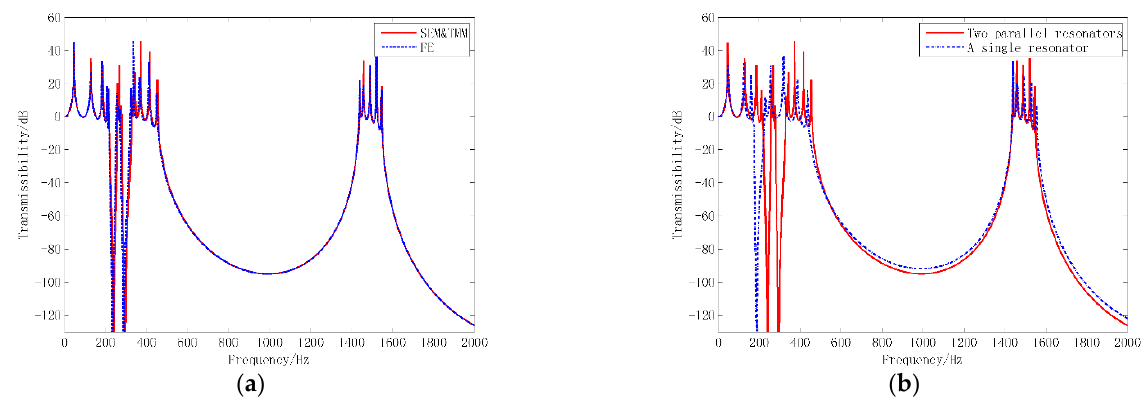
Figure 5. Transmission capability of struts: ( a ) obtained by proposed method and finite element software ( b ) with two parallel resonators and a single resonator. Table 3. Calculated parameters of the